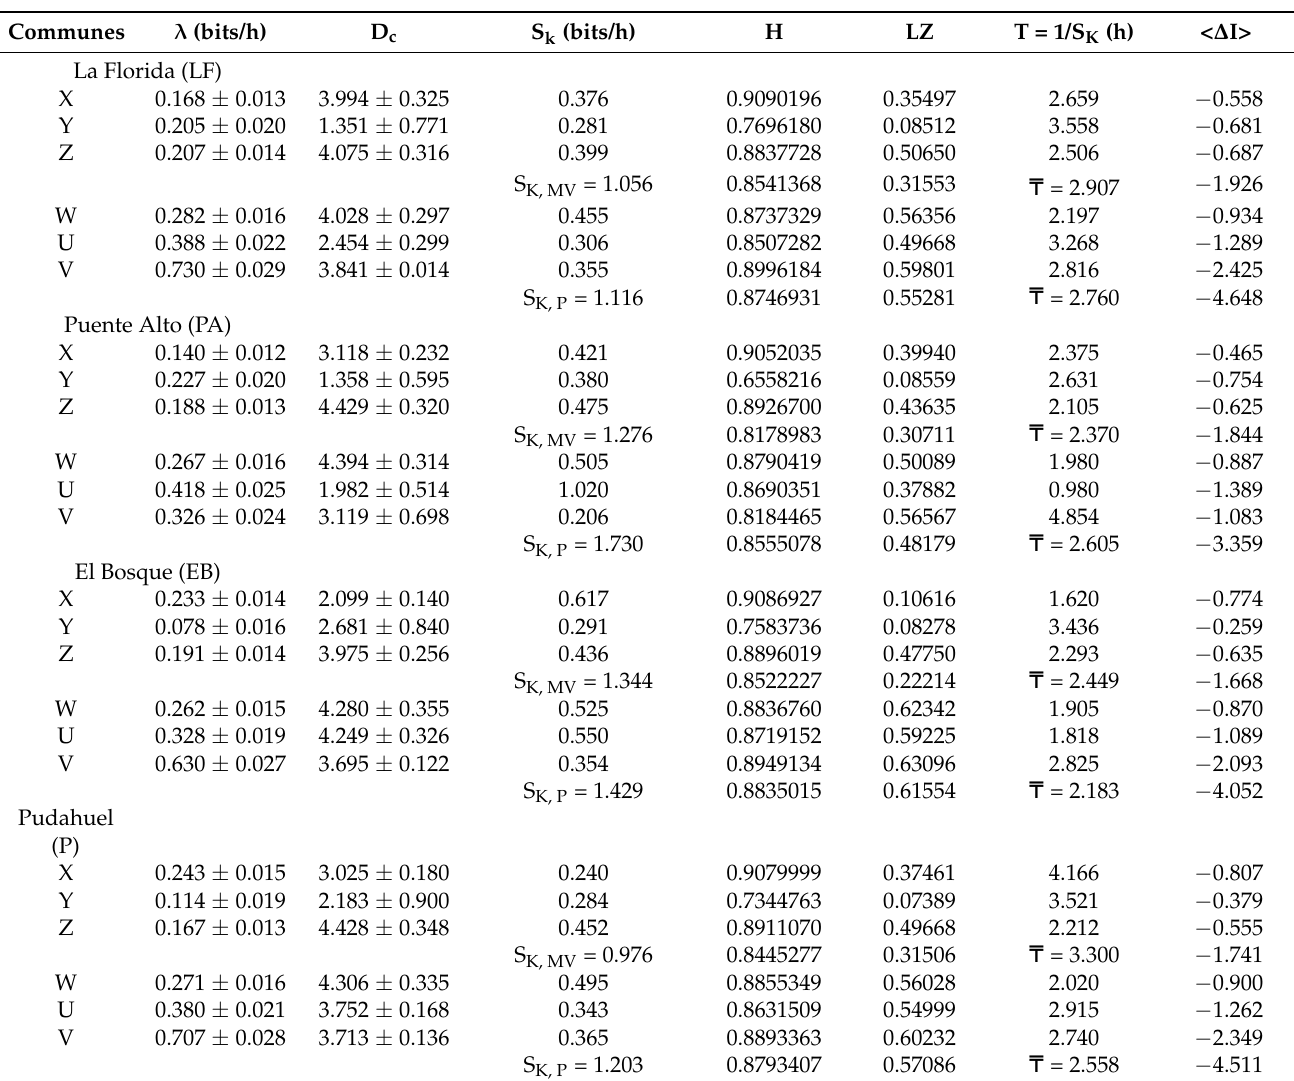
Table 3. Nonlinear parameters [52] by commune and for accumulated sick people, meteorological